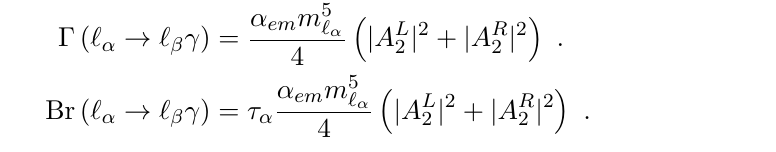
Figure 6 . γ -penguin diagrams contributing to the ‘ − for neutral and 1 , 2 for charged fermions and s corresponding leg-corrections (not shown) are also taken into